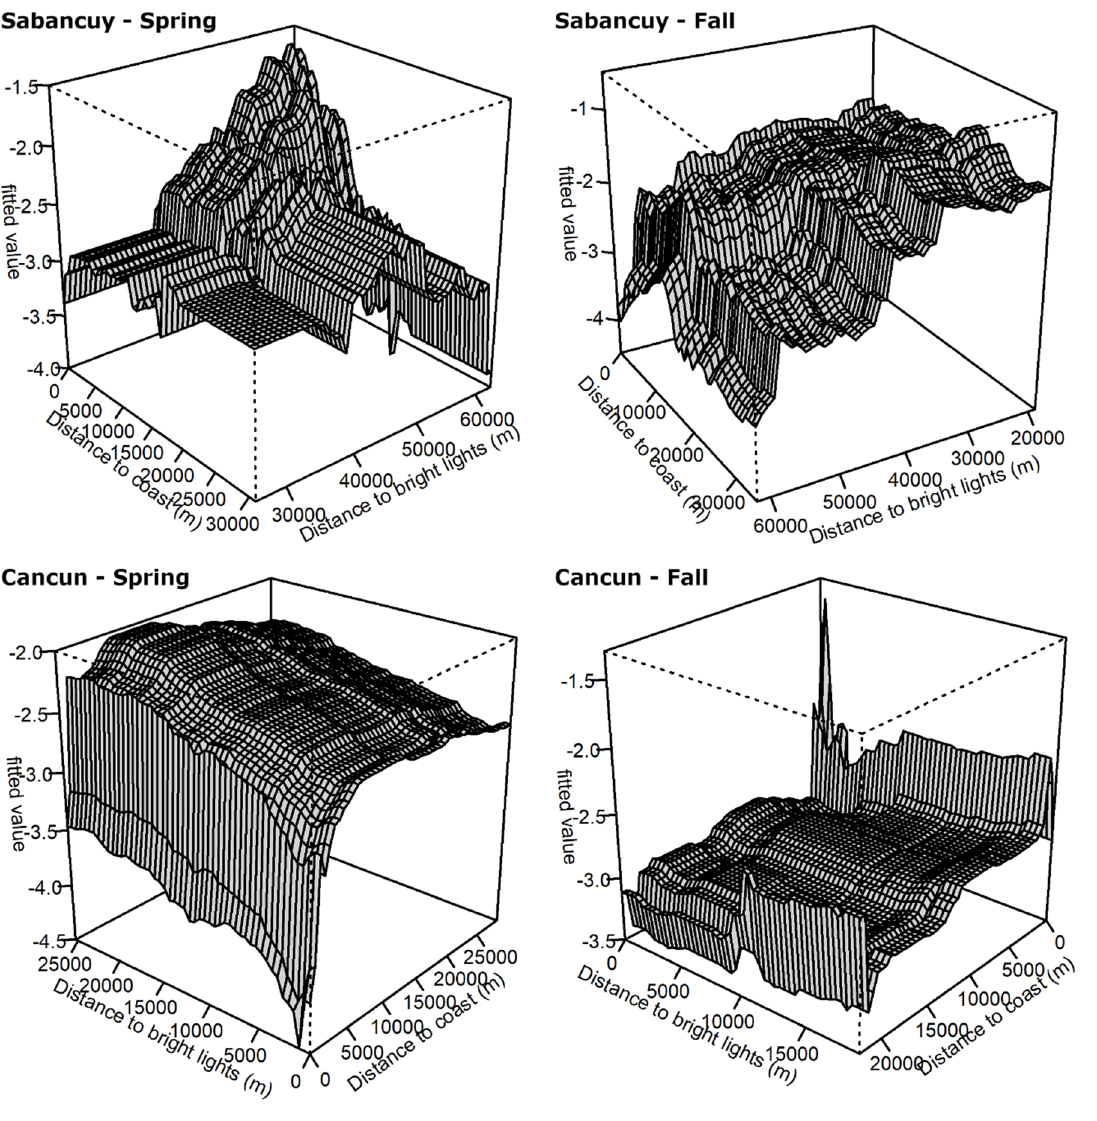
Figure 3. Partial dependency plots for the interaction between distance to the coast and distance to bright lights, from Boosted Regression Tree models of bird densities during migration exodus around two weather radars (Sabancuy and Cancun) located in the Yucatan Peninsula, in spring and fall migration seasons.